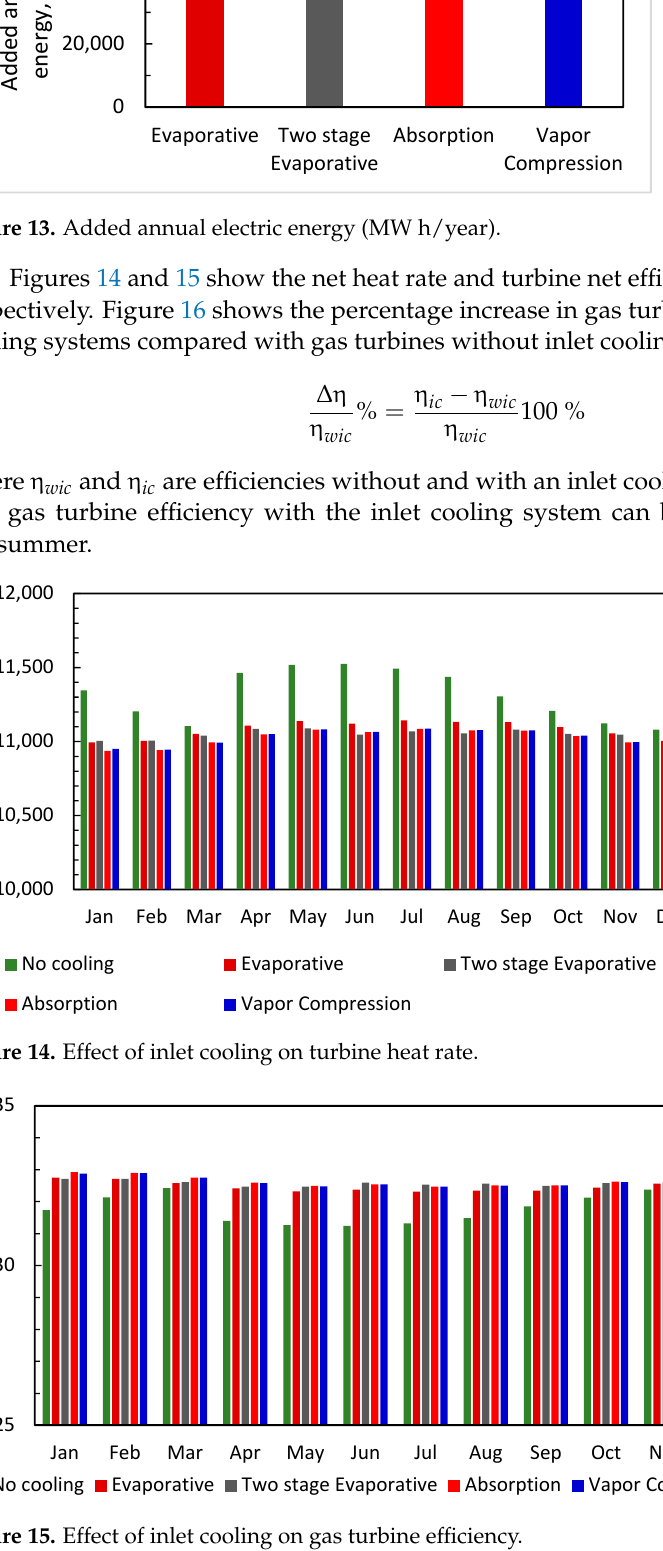
Figure 12. Added power output.